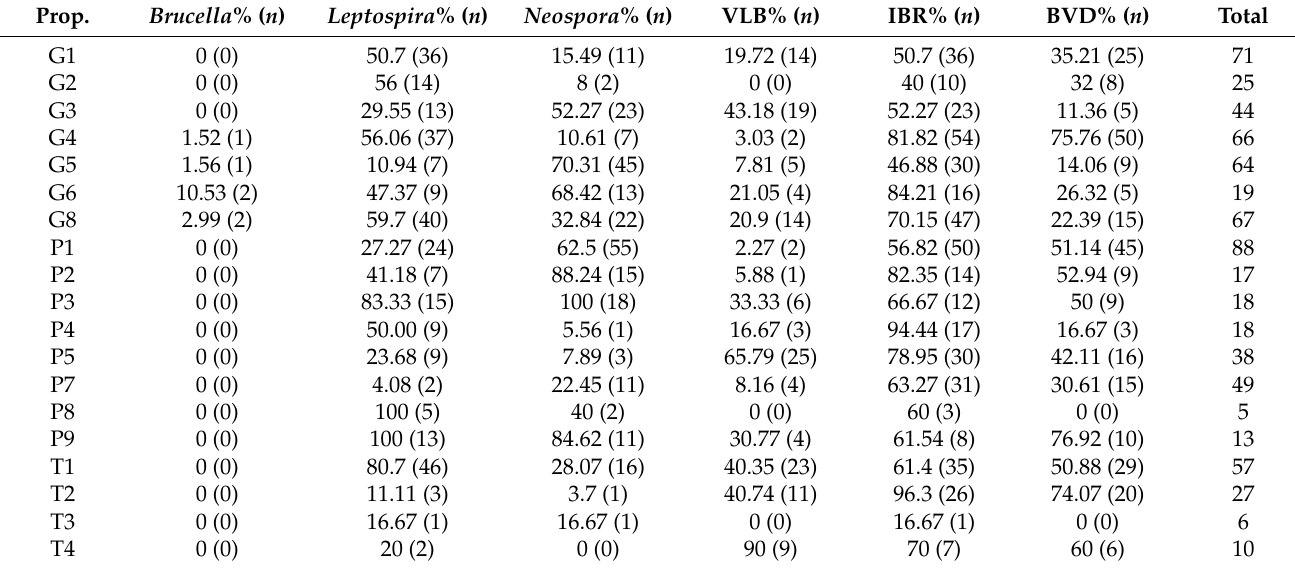
Table 2. Frequency of infections in samples evaluated by SNP markers from Curraleiro P é -Duro cattle herds.